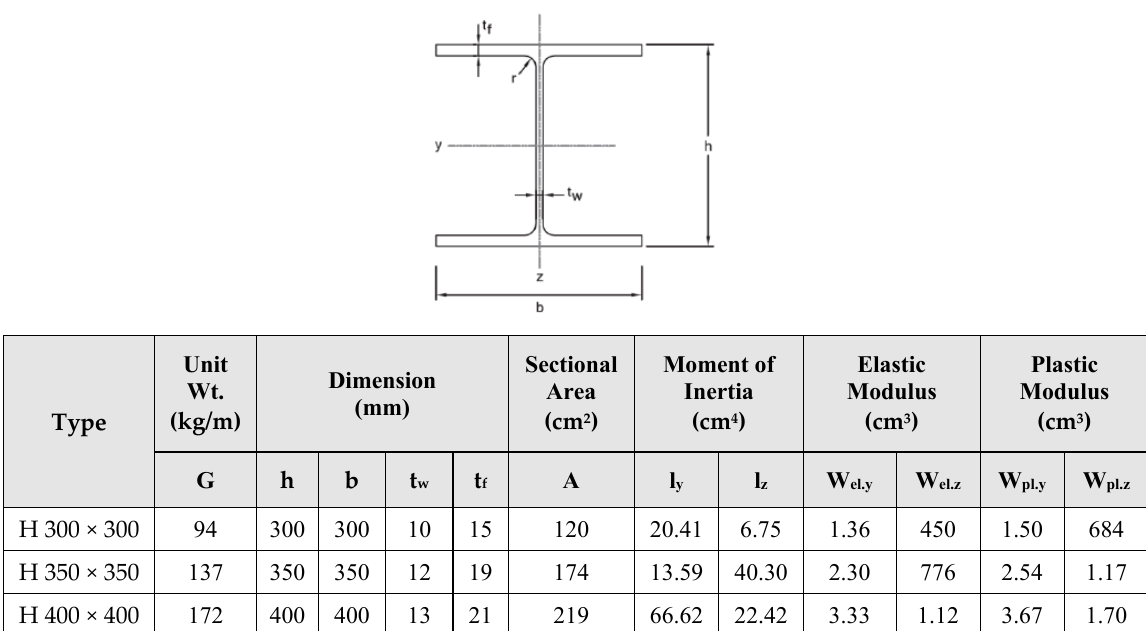
Figure 8. An allowable spacing number (L).